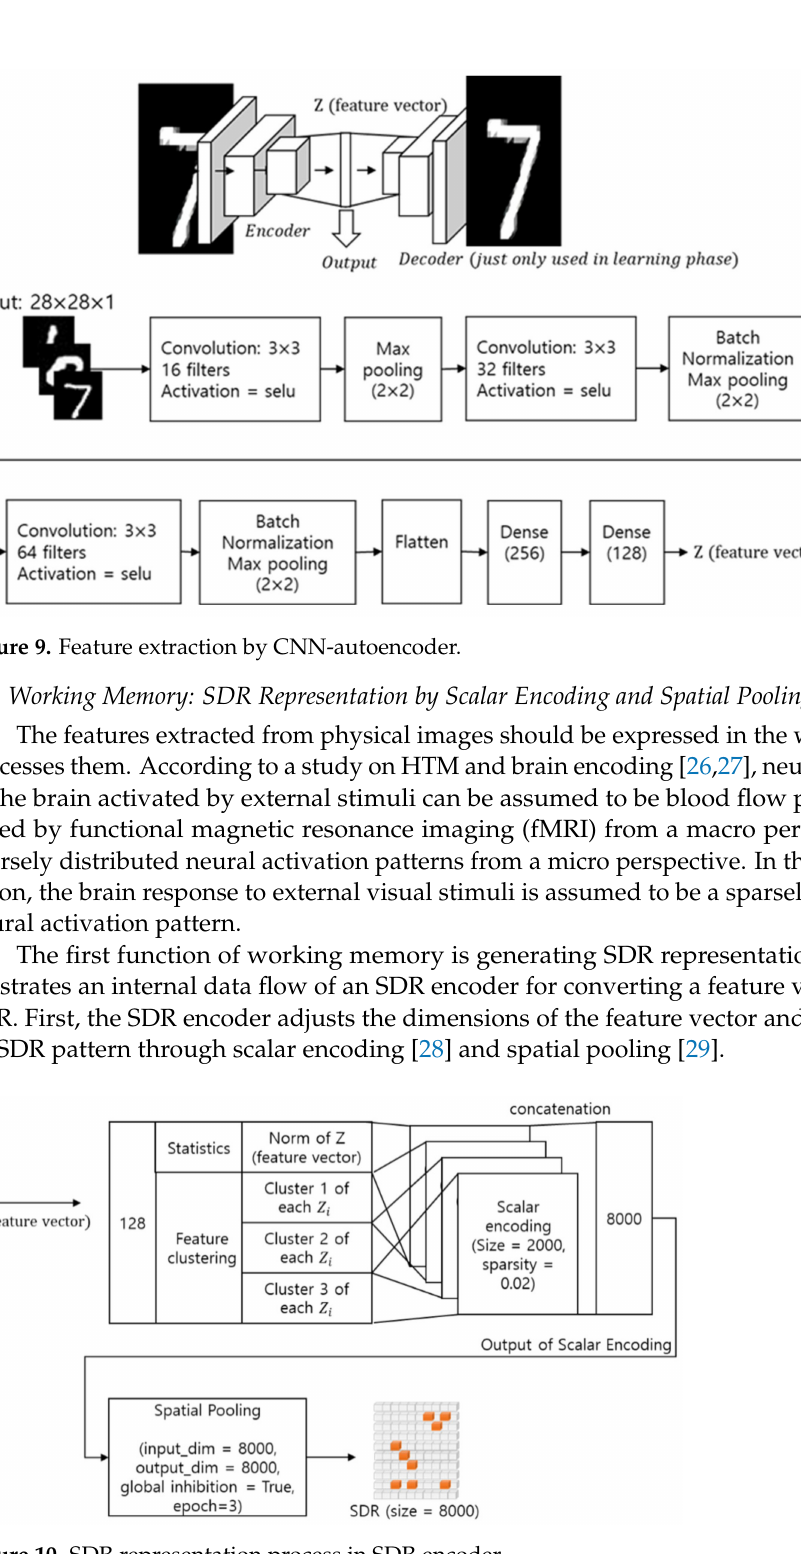
Figure 10. SDR representation process in SDR